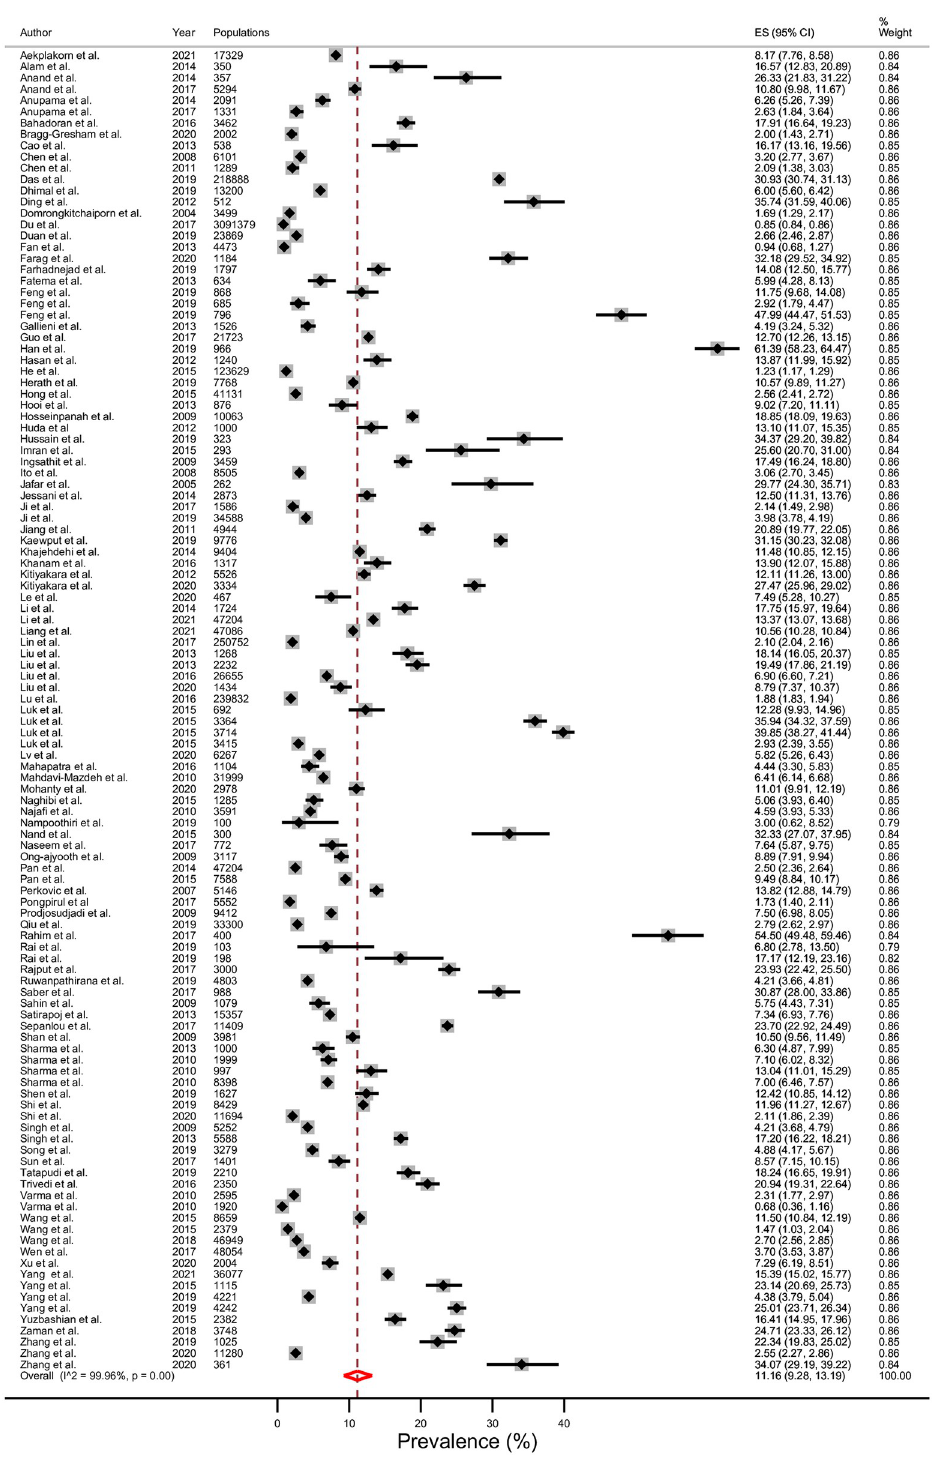
Fig 2. Prevalence of chronic kidney disease (CKD) stages 3–5 in low- and middle- income countries (LMICs) in Asia using a random-effects model.